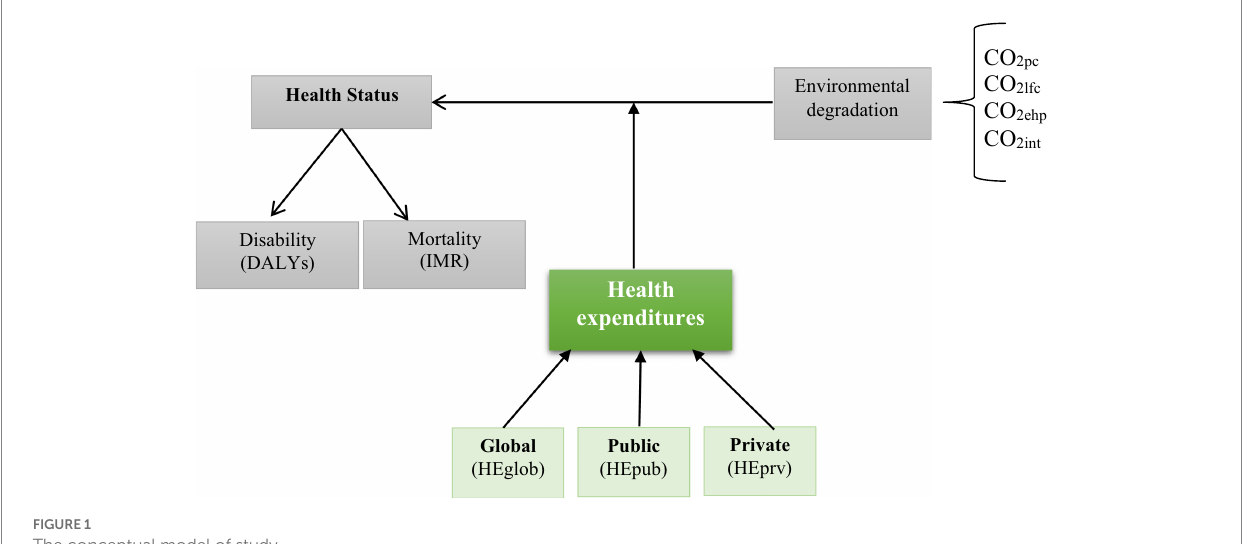
FIGURE 1 The conceptual model of